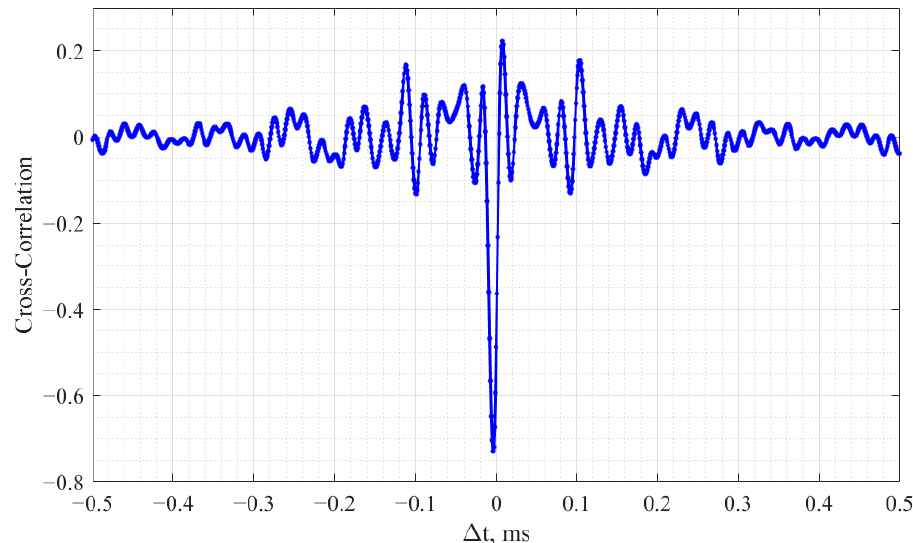
Figure 9. X 1 and X 3 cross-correlation function for RC two-transistor oscillator.